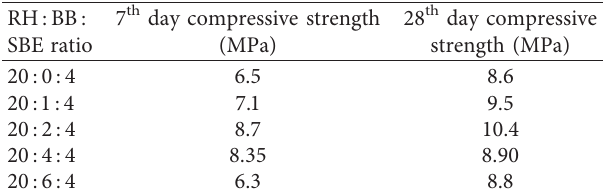
Table 4: Compressive strength of pozzolana-lime cements with various ratios of RH, BB, and